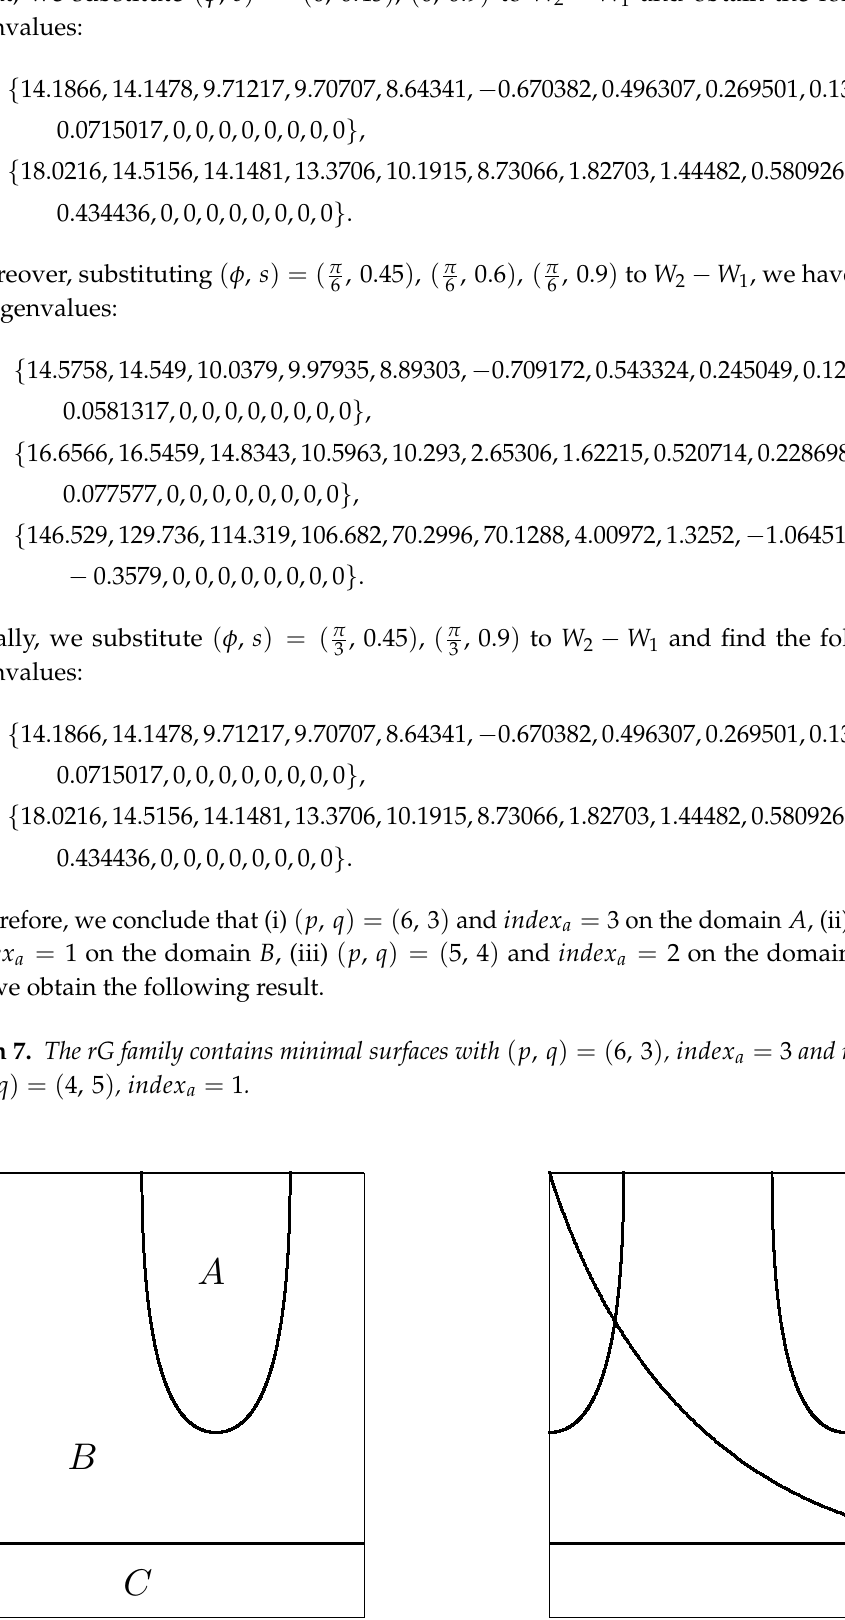
Figure 6. The locus det ( W ) = 0 and that of ( φ , s ) which satisfies (3) in Figure 3.4: The locus det( W ) = 0 and that of ( ϕ, s ) which satisfies (2.3) in π , π ] , 0 . 4 < s < 1 ( ϕ, s ) ϕ ( 6 3 { | ∈ −